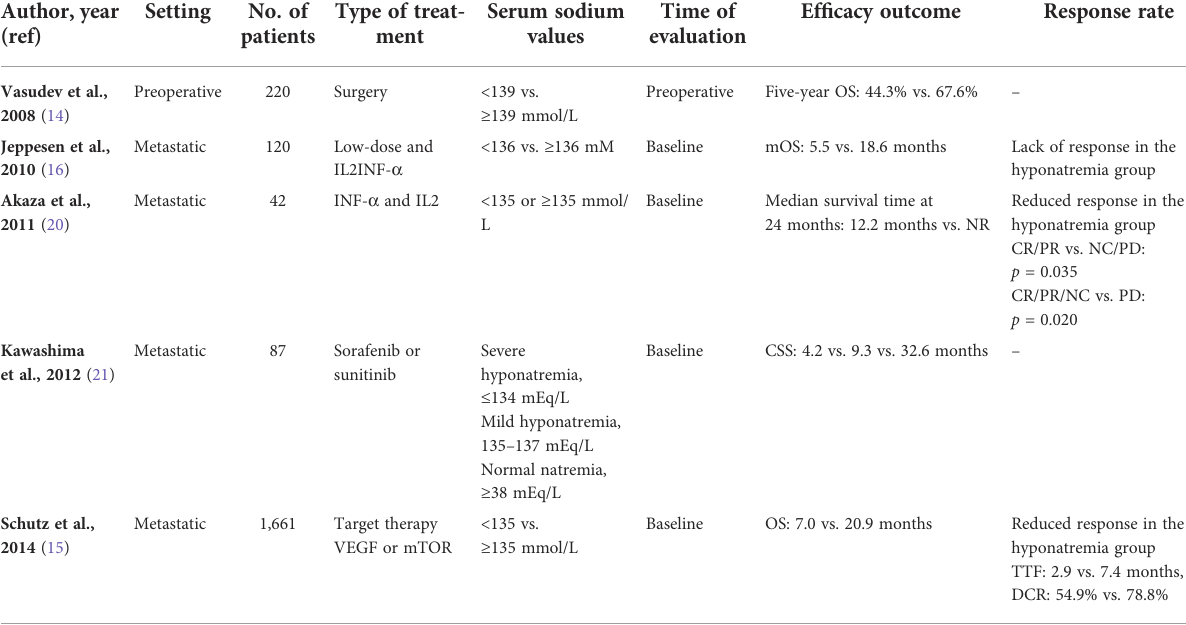
TABLE 6 Previous studies correlating serum sodium values with survival in RCC patients. Author, year